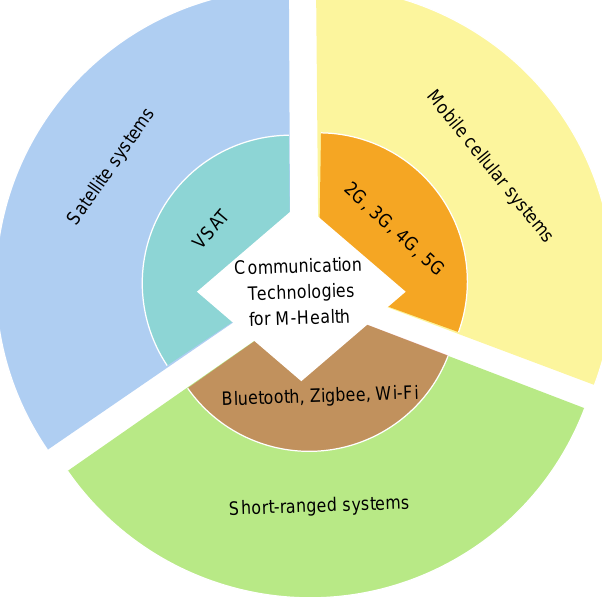
Figure 12. Different communication technologies for mHealth